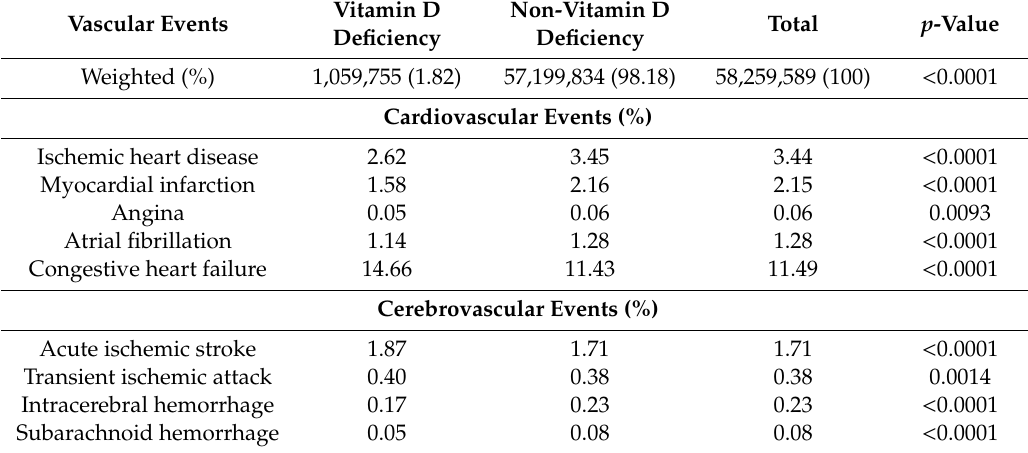
Table 2. Prevalence of cardiovascular diseases and cerebrovascular disorders among hospitalized patients with vitamin D